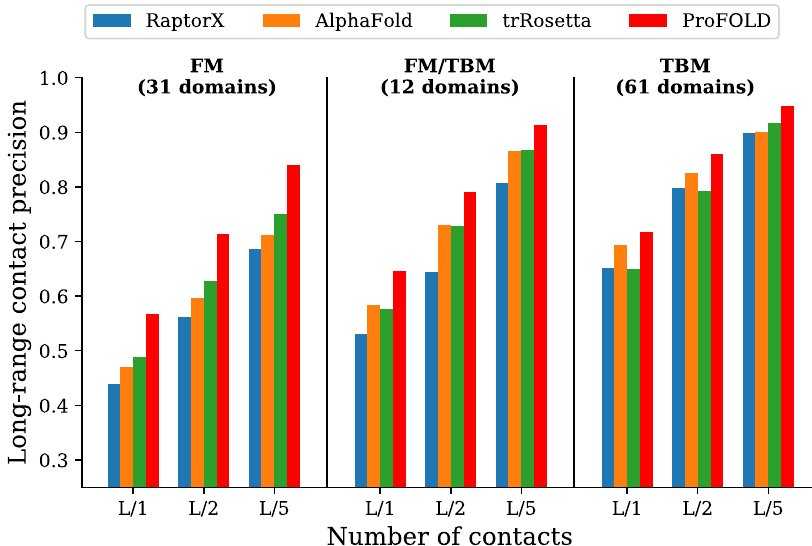
Fig. 3 Precision of the predicted inter-residue contacts. Here, the most probable L /5, L /2 and L long-range residue contacts are shown, where L represents protein length. The phrase "long-range" refers to two residues with sequence separation over 24 residues. For all CASP13 target proteins, ProFOLD outperformed the state-of-the-art approaches. In particular, for the 31 FM domains, ProFOLD achieved precision of 0.840, 0.713 and 0.567 for the most probable L /5, L /2 and L contacts, which is signi fi cantly higher than AlphaFold, by 0.128, 0.117 and 0.097,